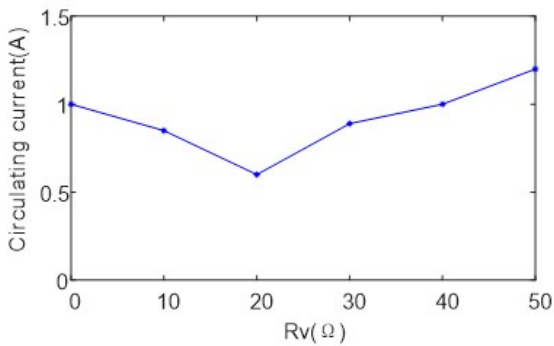
Figure 15. Relationship between circulating current and virtual impedance.